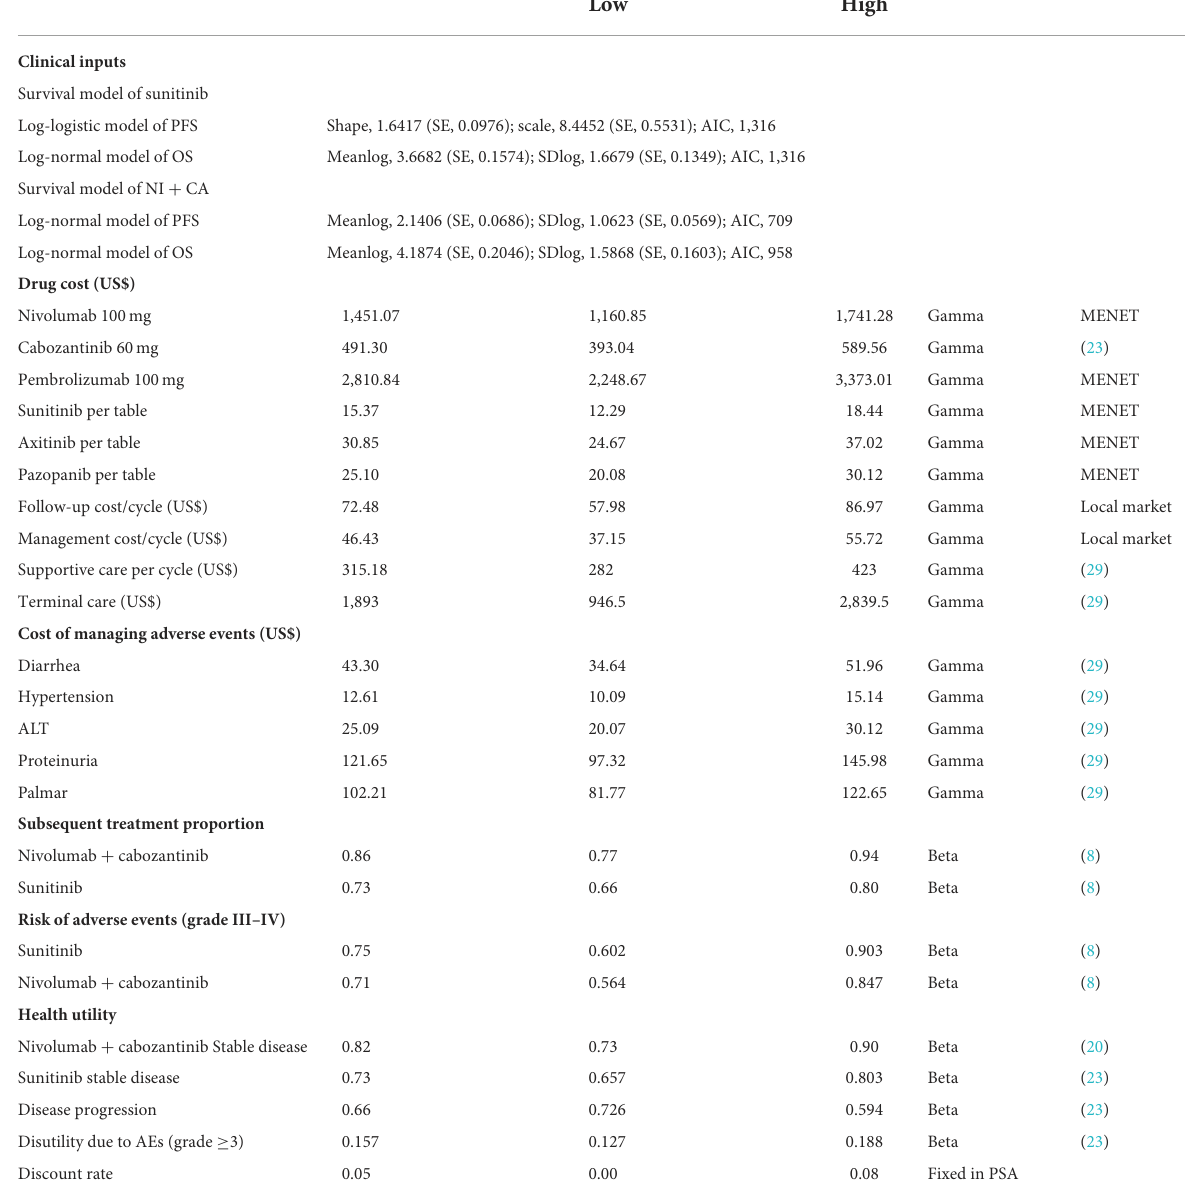
TABLE 1 Summary of main medical costs, utility values, and other parameters. Parameter Base case Range Distribution Source Low